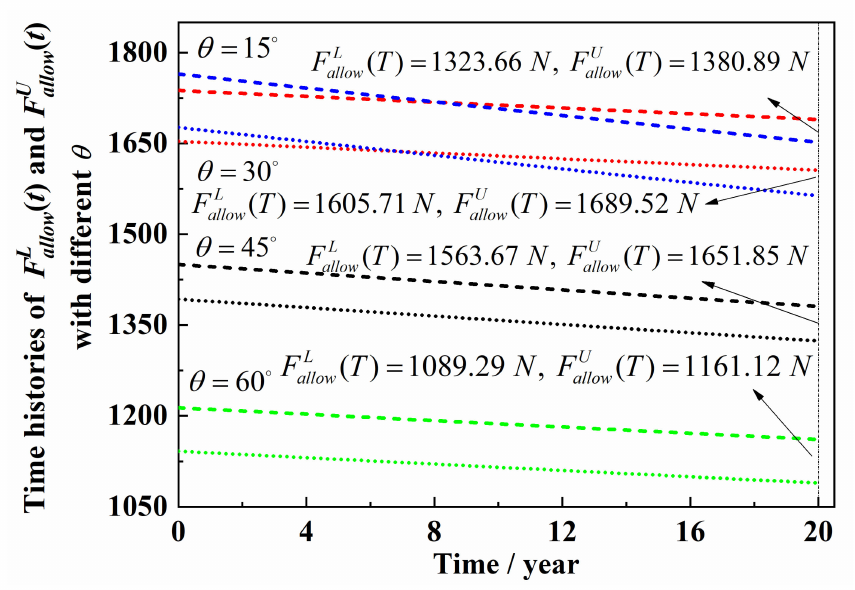
Figure 7. Time history results of F L